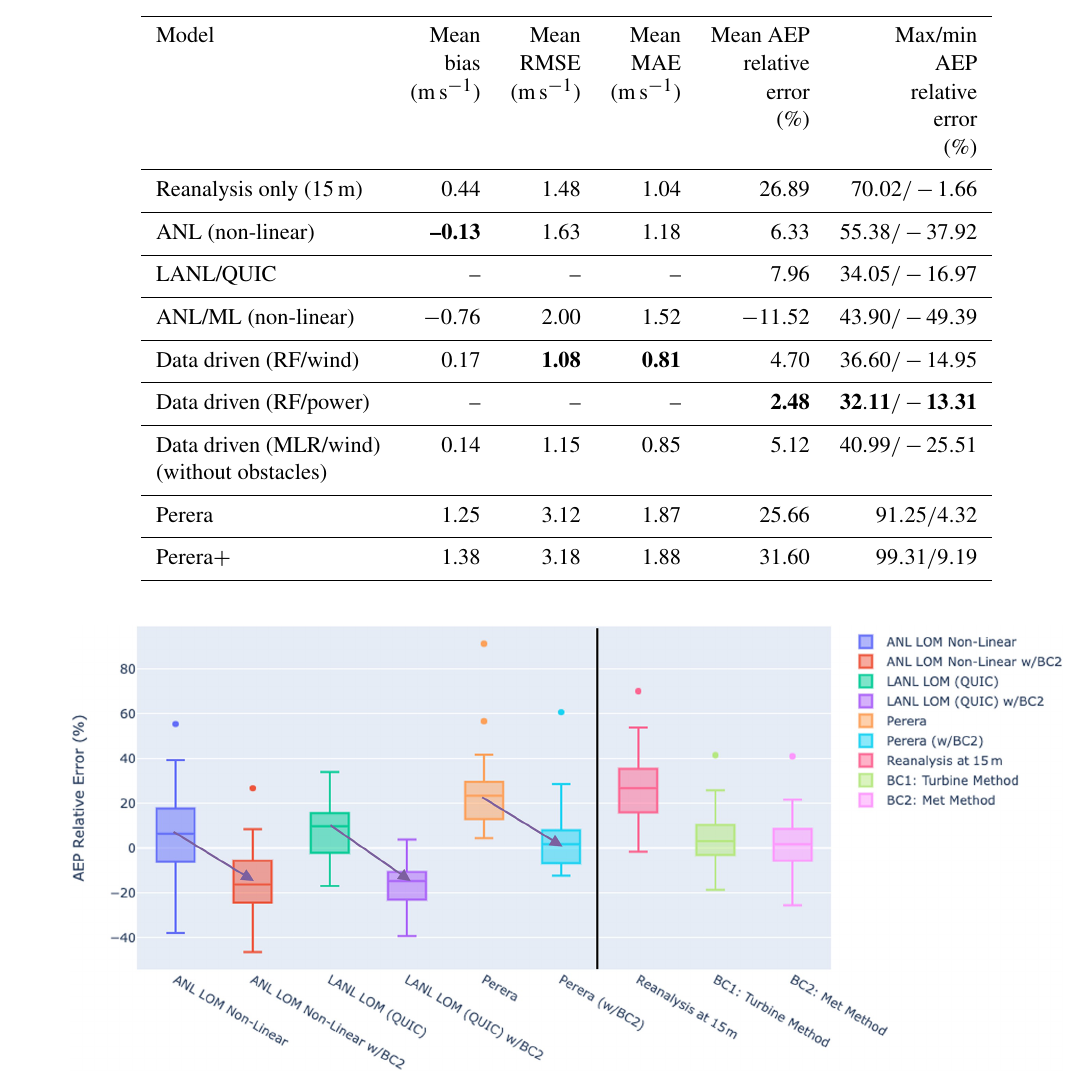
Figure 11. Box and whisker plots showing performance (median, IQR, 90th percentiles, and outliers) for the models studied, both with and without local bias correction applied prior to obstacle impact assessment. The six boxes on the left of the plot correspond to the models with and without bias correction, while the three on the right are the inflow data and bias corrected data without obstacle assessment.